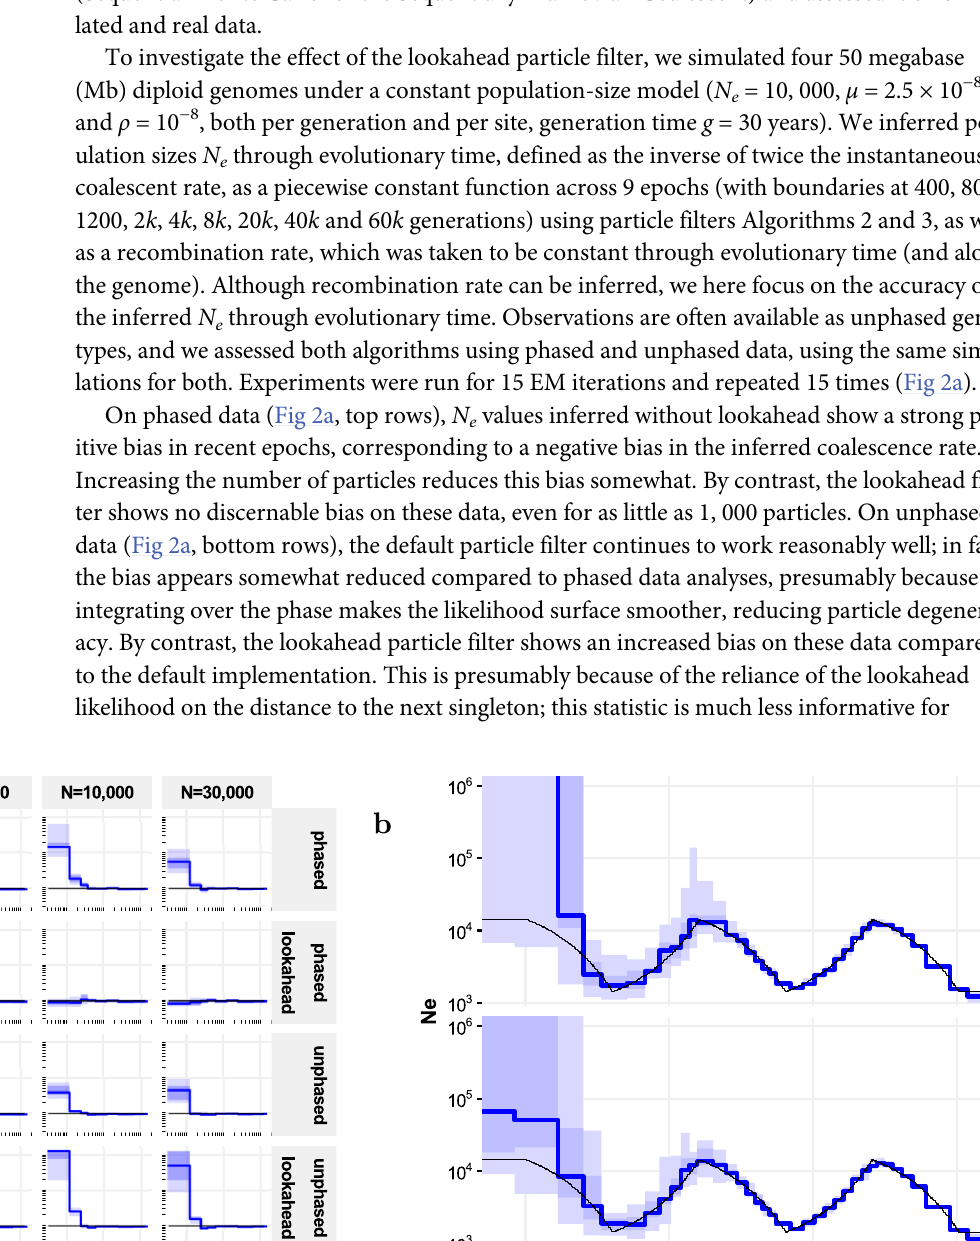
PLOS ONE | https://doi.org/10.1371/journal.pone.0247647 March 2,